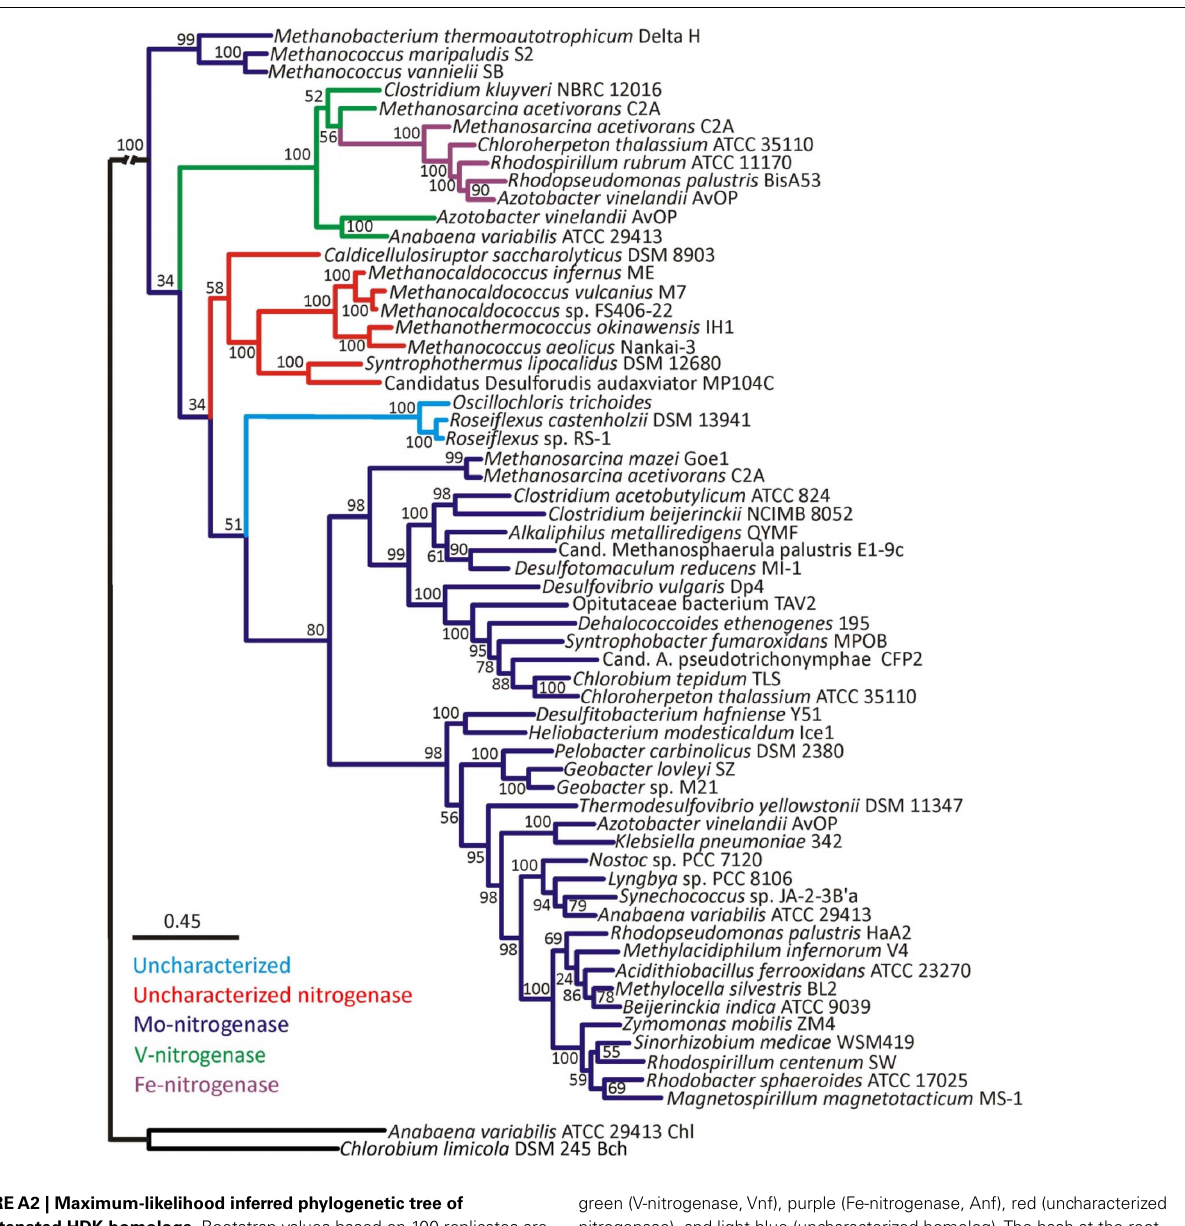
FIGUREA2 | Maximum-likelihood inferred phylogenetic tree of concatenated HDK homologs. Bootstrap values based on 100 replicates are indicated at each node. Branches are colored dark blue (Mo-nitrogenase, Nif),